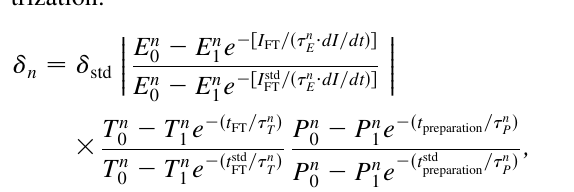
, (b) b , and (c) b . 1 3 5